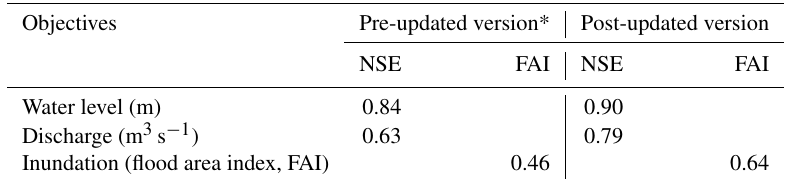
Table 2. Comparison of model performance for the flood event of 2011 between the pre- and post-updated versions. Values show the mean of all stations or satellite images used for the model performance